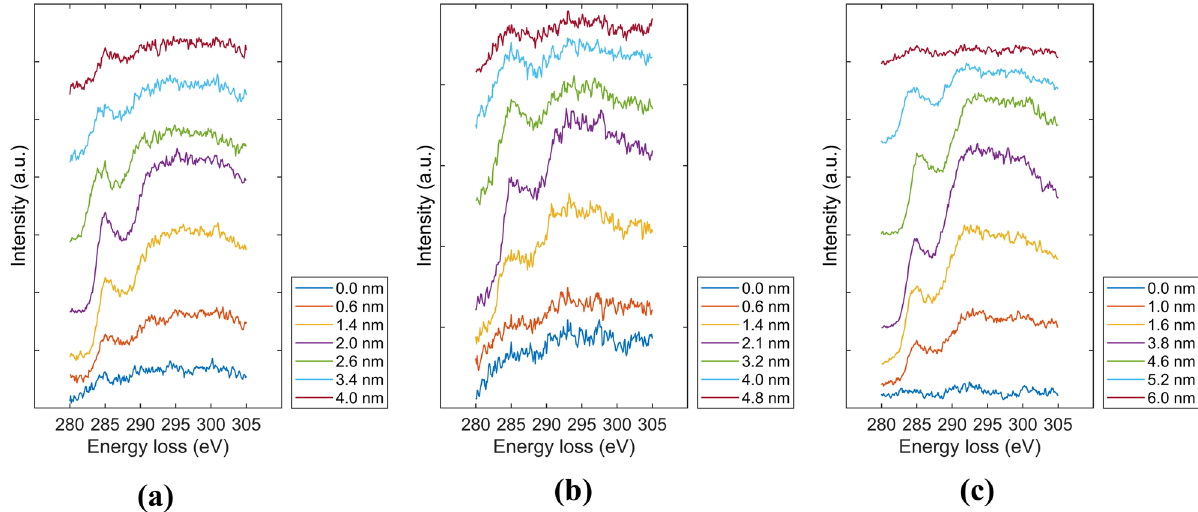
Figure 4. C K-edge EELS spectra of a -C/SiN x /Si stacks: ( a ) untreated and ( b , c ) thermally annealed at 250 °C in Ar atmosphere for ( b ) 30 min and ( c ) 90 min. Representative spectra of the intermixing, bulk, and surface layers of the a -C film were obtained by advancing from the bottom spectra (blue color) of the Si substrate to the top spectra (dark red color) of the Cr capping layer in 0.2-nm